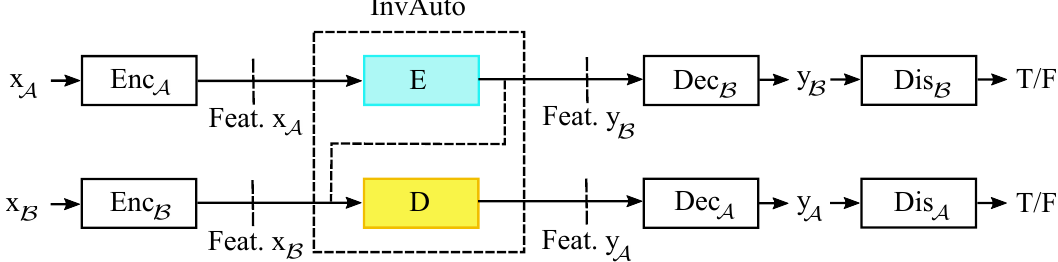
Figure 5. The architecture of the domain translator with InvAuto ( E , D ) . x A ∈ A and x B ∈ B are the inputs of the translator. y B is a converted image x A into the B domain and y A is a converted image x B into the A domain. Invertible autoencoder ( E , D ) is built of encoder E and decoder D , where each of those itself is an autoencoder. Enc A ,Enc B are feature extractors, and Dec A ,Dec B are the final layers of the generators Gen B , i.e., (Enc A , E ,Dec B ), and Gen A , i.e., (Enc B , D ,Dec A ), respectively. Discriminators Dis A and Dis B discriminate whether their input comes from the generator (True) or original dataset